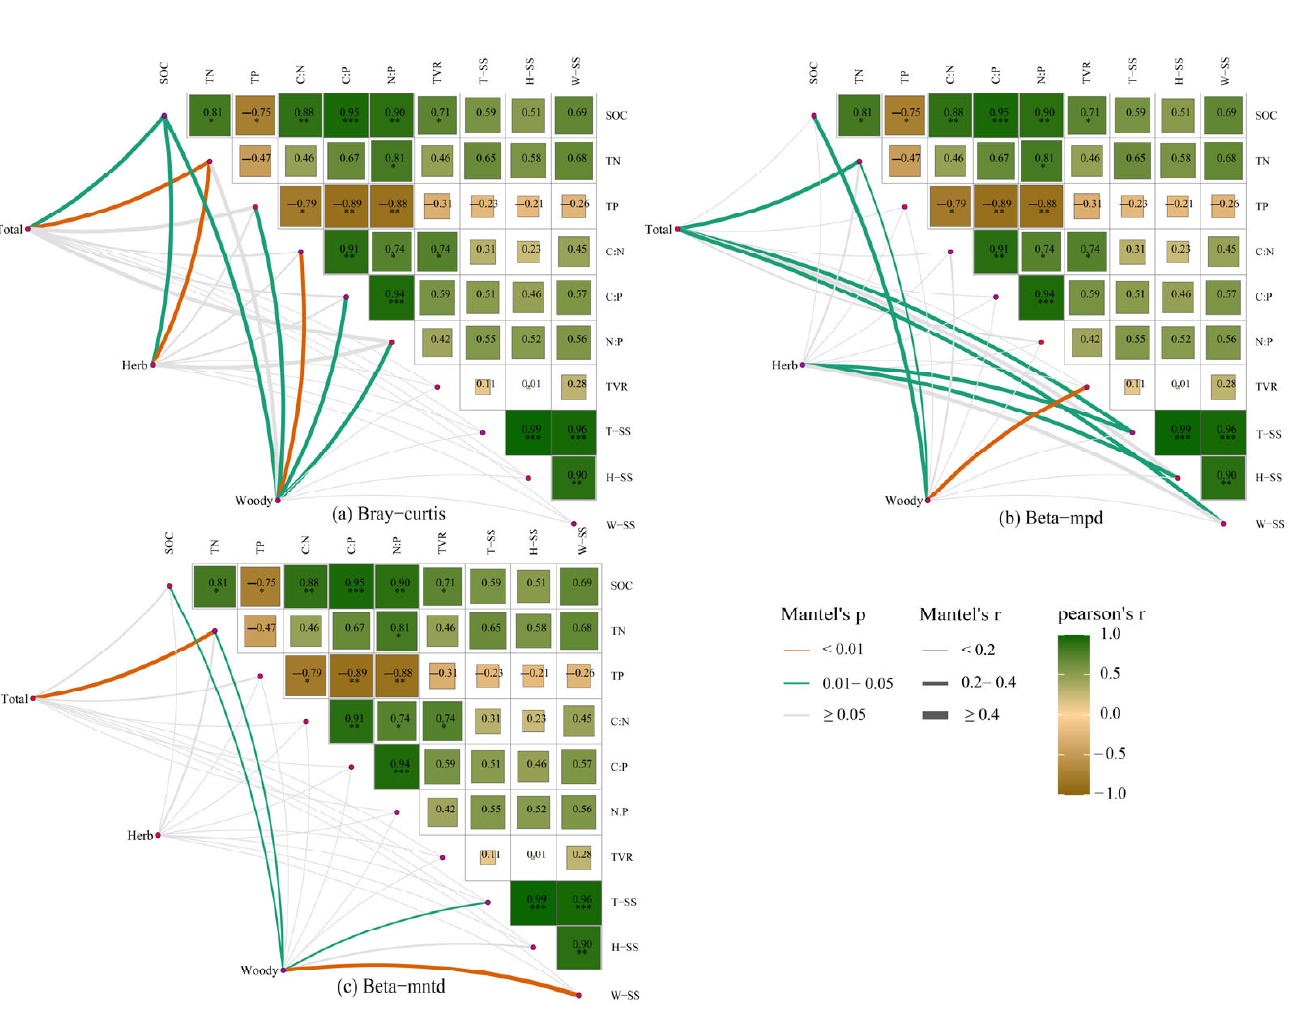
Figure 6. The redundancy analysis on the relationship between plant community β‐ diversity and soil C:N:P stoichiometry, TVR, and SS. TVR indicates the time after vegetation restoration (in years).